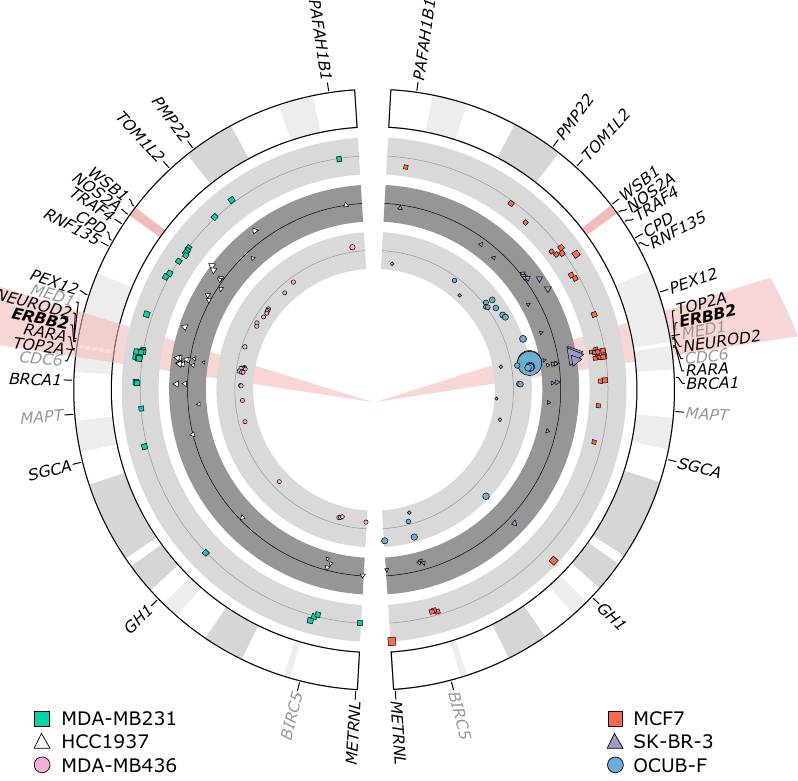
Figure 2. MLPA results of chromosome 17 of all cell lines used. Cell lines MDA-MB231, HCC1937, MCF7, SK-BR-3, OCUB-F and MDA-MB436 are shown. Probemix P004-B1 and P078-B1 (greytone) were used on all cell lines. The HER2 gene is highlighted in red. The size of the used pictograms corresponds to the reach of the MLPA results (bigger size correlates to higher reach). Results between the probemixes were concordant. The P078-B1 breast tumour probemix also contained probes for genes located on other chromosomes relevant for breast carcinoma and reference genes. In these genes no polysomy or loss or amplification could be detected (not shown in the figure). Negative controls used, were nicely oriented around 1,00 (not shown). The MLPA results with probemix P004-B1 and P078-B1 (greytone) of cell lines MDA-MB231 and HCC1937 show no polysomy or loss or amplification of HER2 . MCF7 shows partial loss of the HER2 gene, corresponding to FISH results (Table 1). SK-BR-3 shows amplification of the HER2 gene corresponding to IHC results and FISH results (Fig. 1). OCUB-F shows amplification of the HER2 gene corresponding to the IHC and FISH results (Table 1). MDA-MB436 shows partial loss of all tested genes on chromosome 17, concordant with monosomy, as was seen with FISH (Fig.